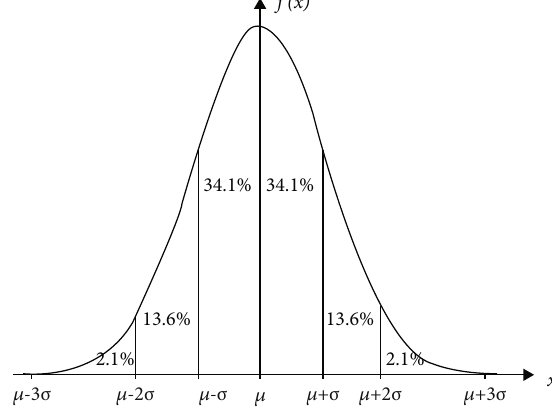
Figure 11: Probability density distributions function. P f ∣ x − μ ∣ < σ g = 0 : 682 ; P f ∣ x − μ ∣ <2 σ g = 0 : 954 ; P f ∣ x − μ ∣ <3 σ g = 0 : 997